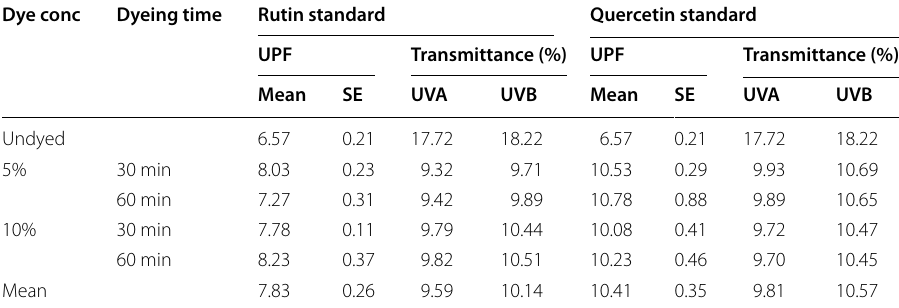
Table 11 Mean UV protection values of cotton dyed with Rutin and Quercetin standards Dye conc Dyeing time Rutin standard UPF